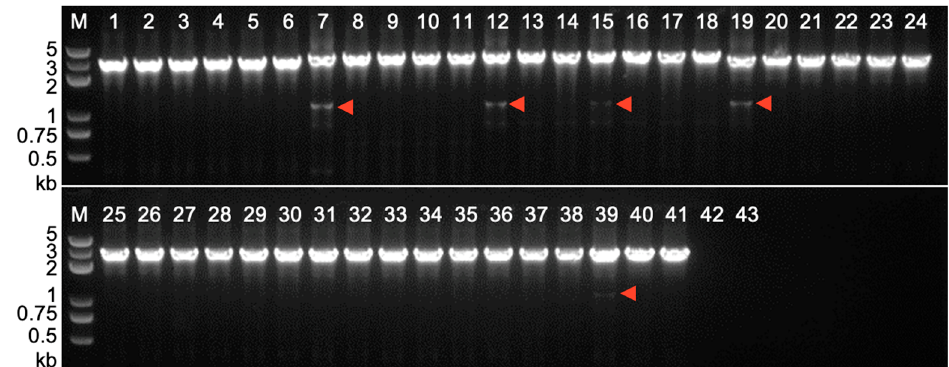
Figure 6. PCR amplification of somatic excision products for dHel in F 1 segregants from test-crosses between different c1-dHel-GFP T 2 transgenic plants and the c1 tester line. PCR primer pairs are shown in Figure 1A. Lanes 1–6, S3-Hel1613; lanes 7–11, S3-Hel1158; lanes 12–18, S3-HelA2; lanes 19–23, S4-Hel1-4; lanes 24–28: S2-Hel1-4; lanes 29–34, S3-Hel1-4; lanes 35–41, S1-Hel1-4; lanes 42–43: F 1 individuals from a non-transgenic line crossed to the c1 tester. Red arrows, PCR products with the expected size for dHel excision products. Table 2. Somatic excision activity in F 1 segregants from different c1-dHel-GFP T 2 transgenic plants.